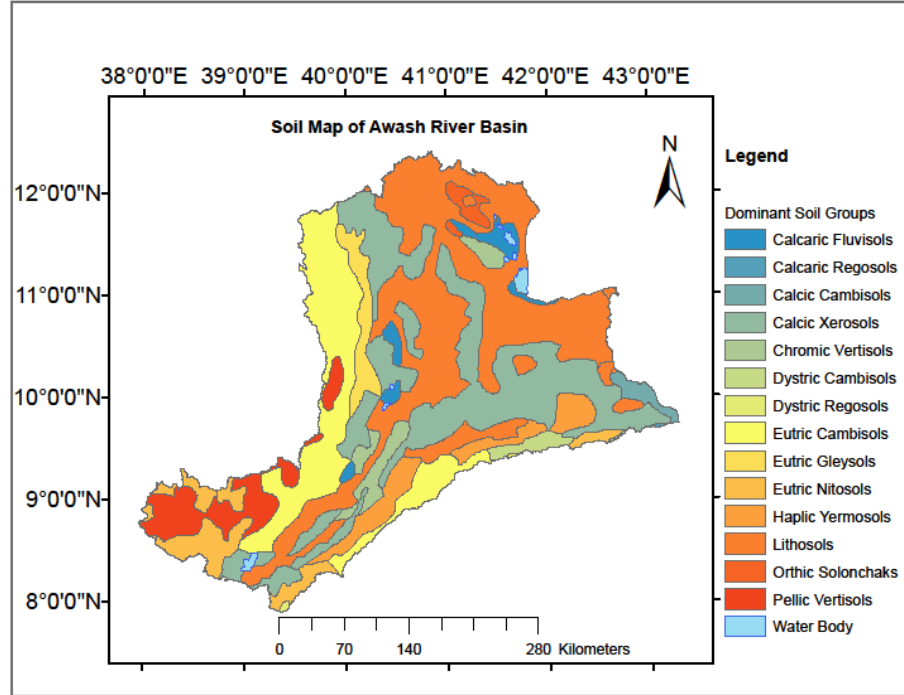
Figure 2. Soil map of the ARB in Ethiopia.